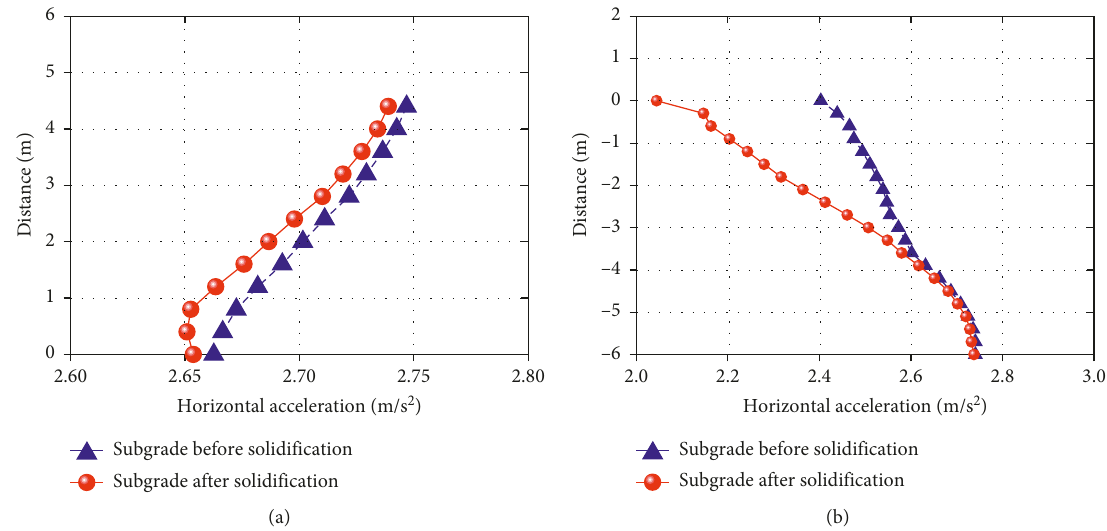
Figure 18: Horizontal accelerations of the subgrade top and the right slope of the subgrade before and after strengthening. (a) Subgrade top. (b) The right